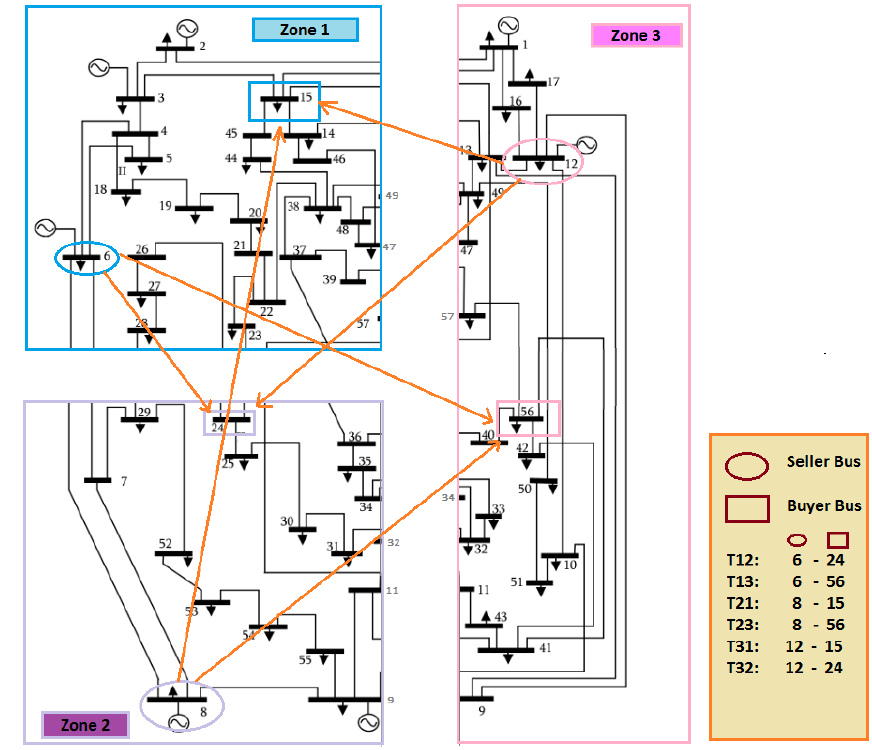
Figure 7. IEEE 57-Single line diagram and investigated inter-zone transactions [37]. Table 5. Considered inter-zone bilateral